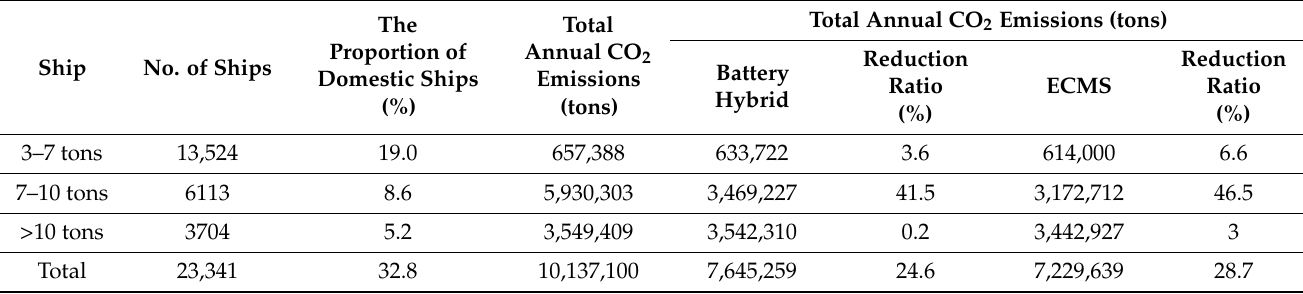
Table 7. Battery hybrid fishing boat with ECMS control algorithm operating results for